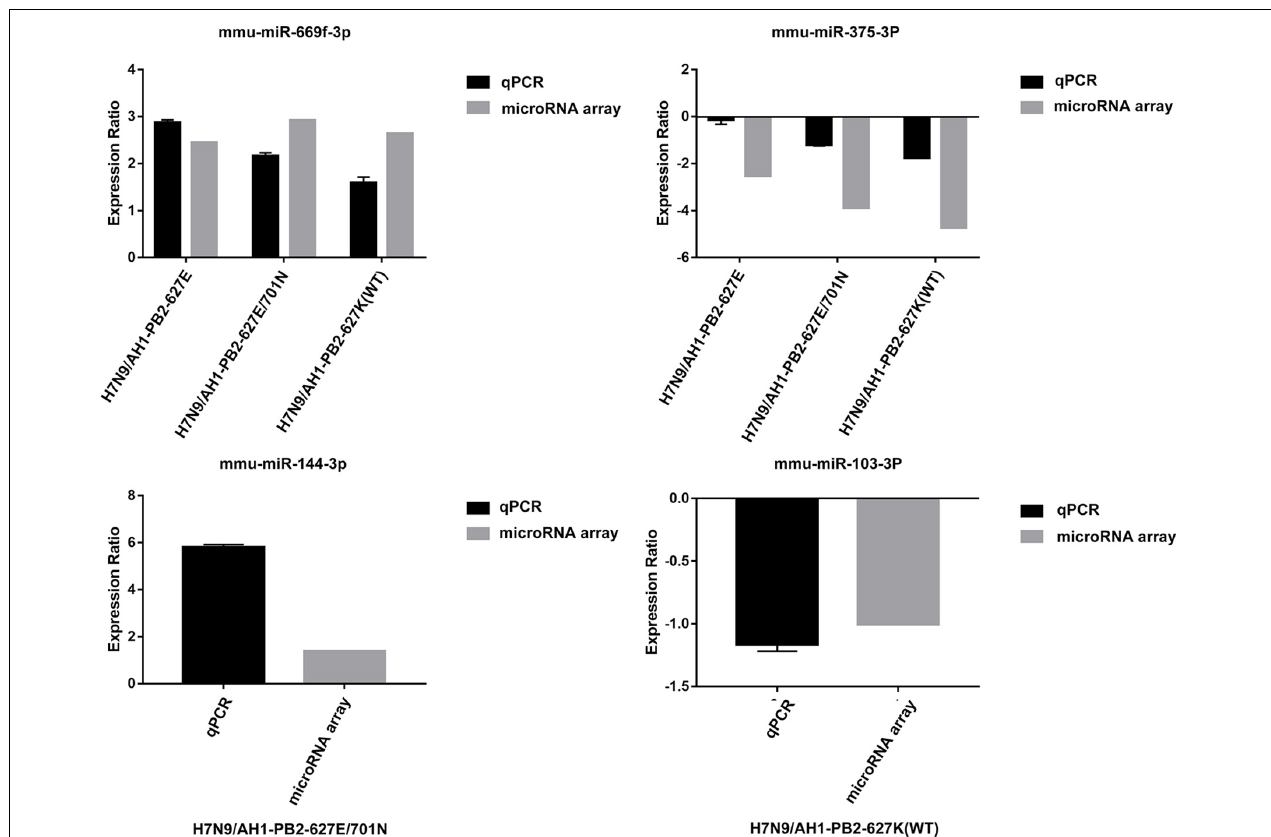
FIGURE 9 | Comparison between microarray data and qRT-PCR